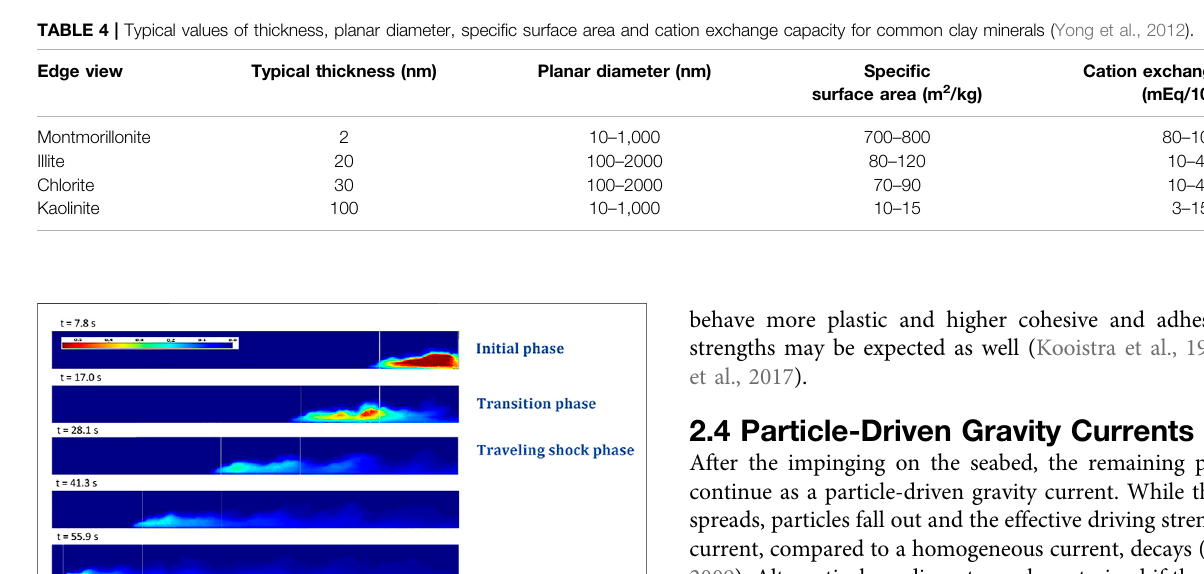
Frontiers in Earth Science |